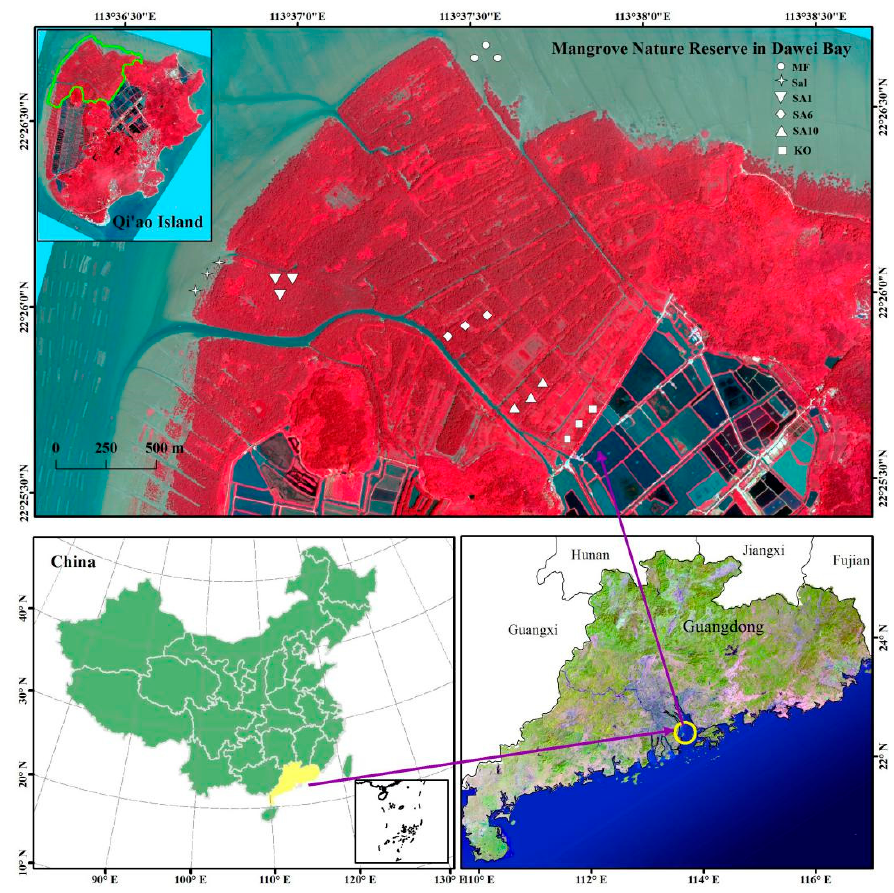
Figure 1. Map of the study sites in Qi’ao Island in Guangdong, China.